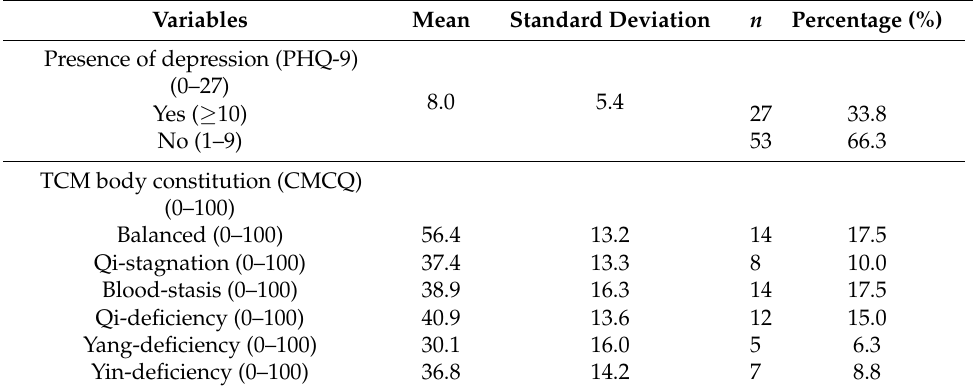
Table 2. Prevalence of depression, traditional Chinese medicine body constitutions, dysfunctional attitude, stress, perceived stress, and self-esteem among